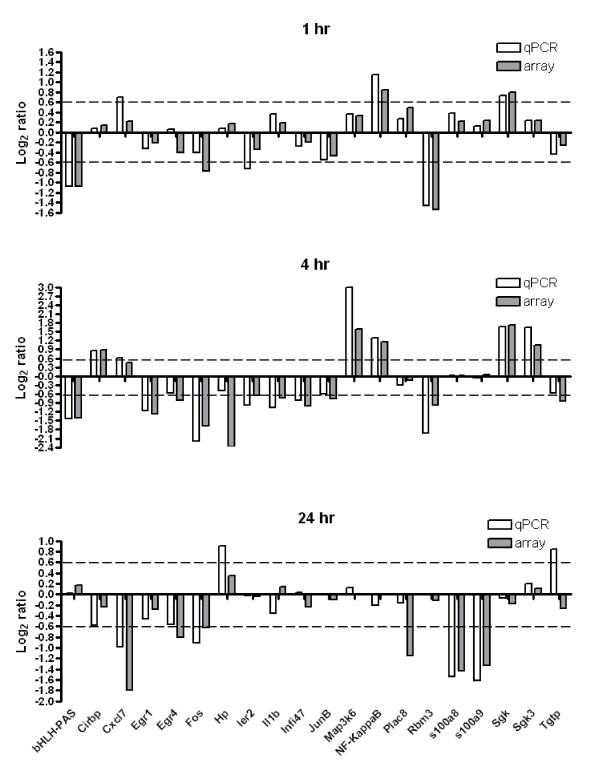
Validation of microarray results by real-time PCR. Dashed line indicates 1.5 fold change.